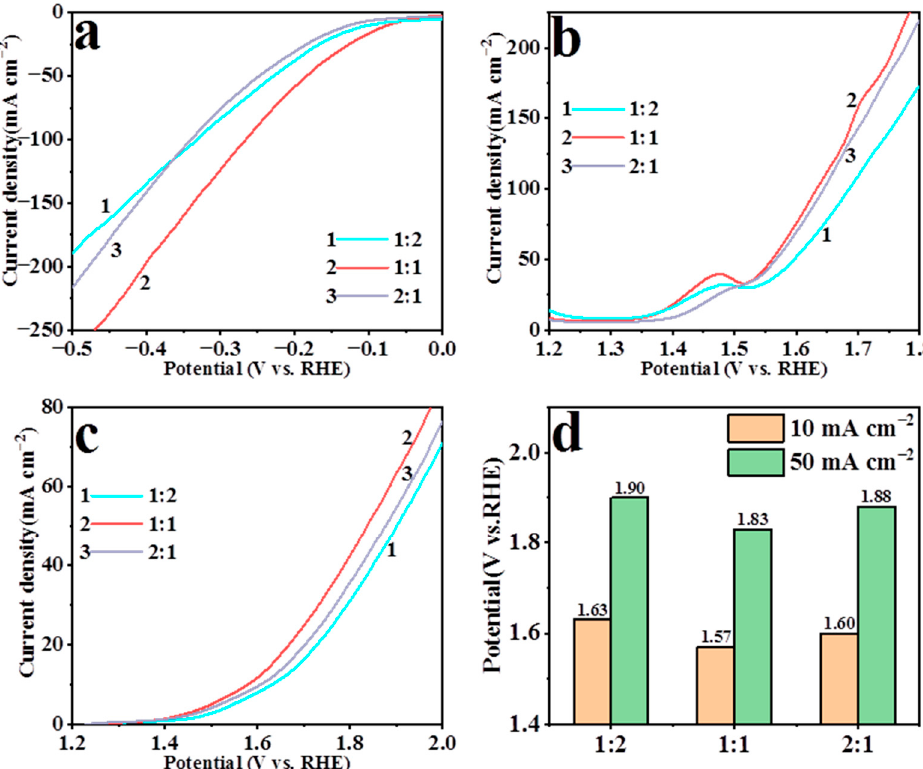
Figure 4. The LSV curves for HER ( a ) and OER ( b ) of CoP@ZIF-8/pNF prepared with different Co-Zn ratios. The LSV curves for water splitting ( c , d ) of CoP@ZIF-8/pNF (+|| − ) prepared with different Co-Zn ratios.